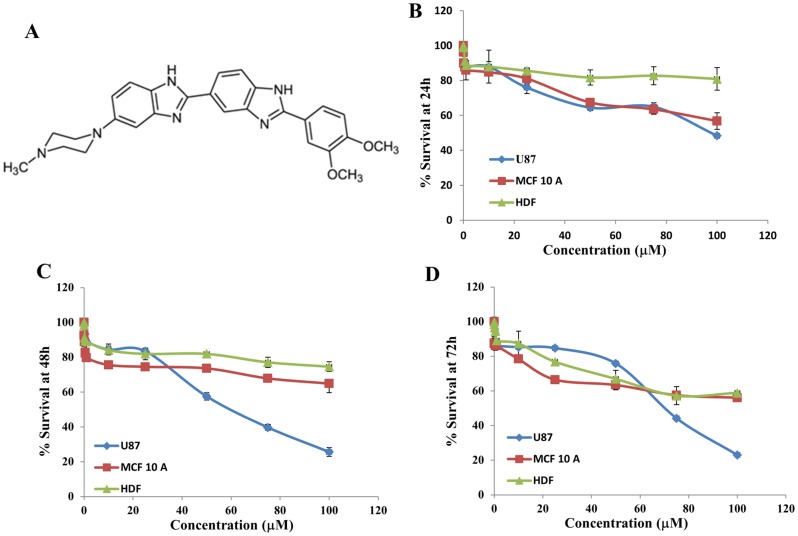
Effect of DMA on survival of HDF, MCF10A and U87 cell lines.(A) Structure of the DNA minor groove binding ligand DMA –5-(4-methylpiperazin-1-yl)-2-[2′-(3,4-dimethoxyphenyl)-5′-benzimidazolyl] benzimidazole.(B) Effect of varying concentrations of DMA on metabolic viability studied by MTT assay in exponential growing HDF,MCF10A and U87 cells at 24 h, (C) At 48 h (D) At 72 h.Values are mean (±SD) of three independent experiments.Statistical significance by T-test p<0.05.